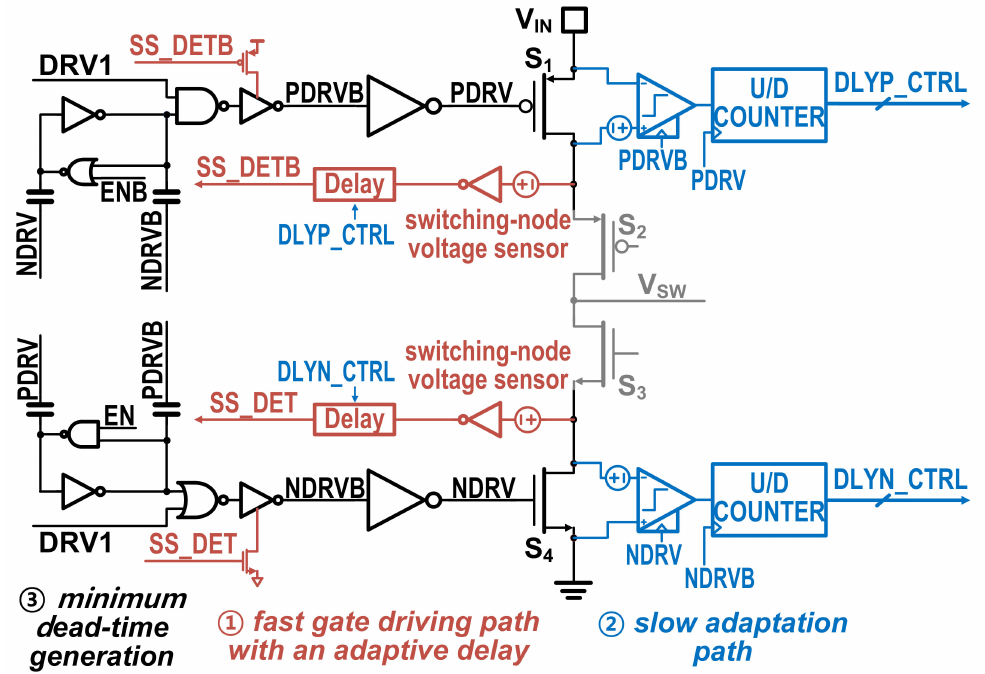
Figure 5. Circuit implementations of soft-switching timing generator for S 1 and S 4 with minimum dead time, gate drivers, and output power